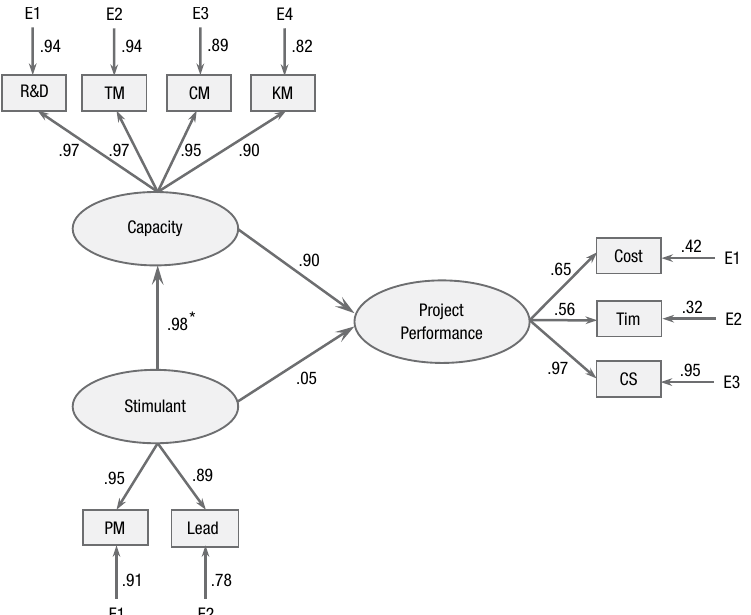
Fig. 1. Innovation’s effects on the performance of capital